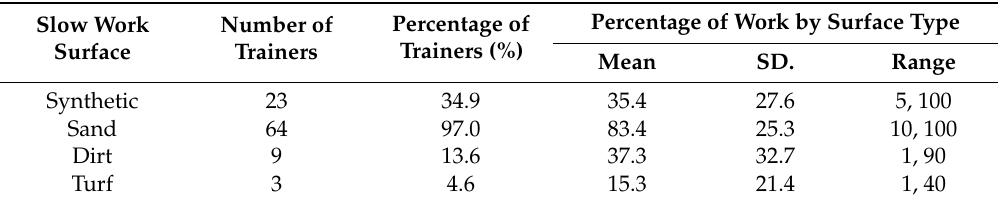
Table 1. Percentage of Thoroughbred trainers (n = 66) using each surface type for slow workouts, and the mean percentage of workouts spent on each surface used in Victoria, Australia.